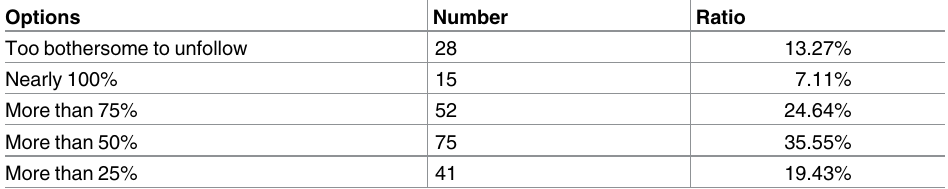
Table 4. What’s the maximum threshold (as a percentage of your recently receivedmessages) you can bear before considering unfollowing